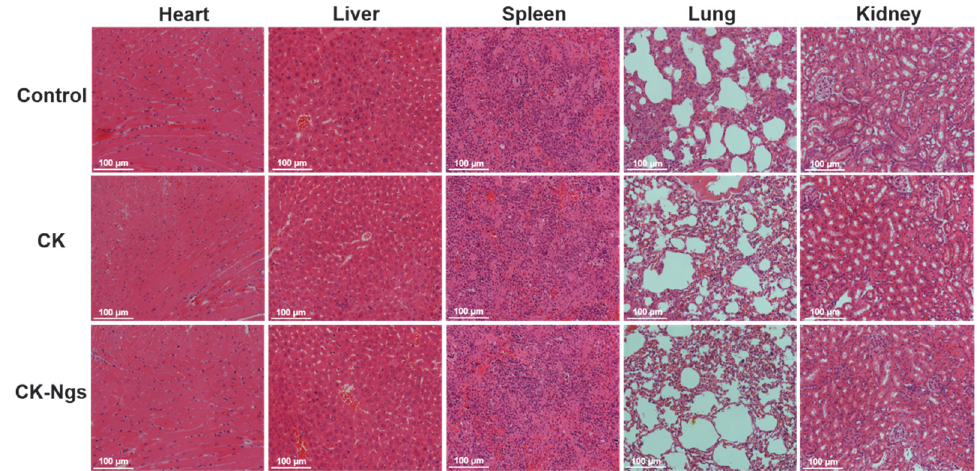
Figure 12. H&E staining of CK and CK-Ngs on main organs of tumor-bearing nude mice (Magnification 20× and scale bar is 100 μ m).